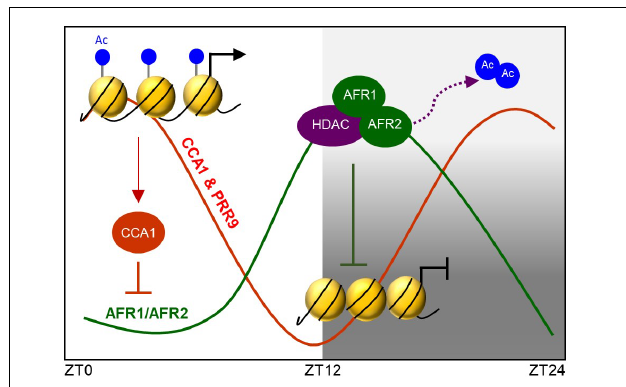
FIGURE 8 | AFRs temporally regulate CCA1 and PRR9 genes during evening time. Arabidopsis Sin3-HDAC participates in regulating rhythmic expression of the CCA1 and PRR9 genes. The evening-expressed AFR proteins may temporally form the Sin3-HDAC corepressor complex and bind directly to the CCA1 and PRR9 promoters to catalyze H3 deacetylation at the cognate regions, allowing the declining phase of CCA1 and PRR9 expression during evening time. Binding regions of the Sin3-HDAC complex are likely specified by LNK-associated DNA-binding